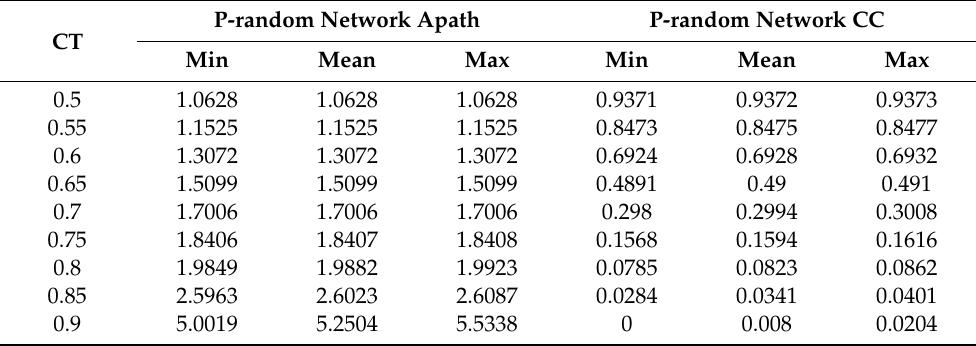
Table 5. The average path length and the global clustering coe ffi cient for a random network.